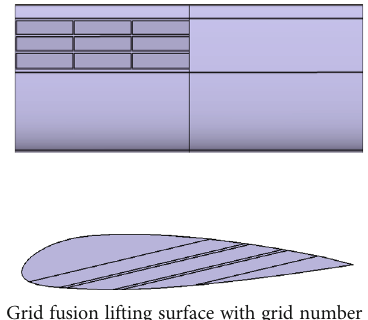
Figure 12: Calculation model of lifting surface with di ff erent grid